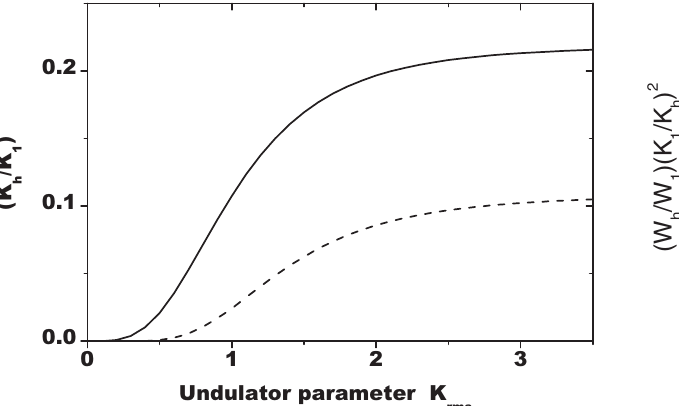
(cid:2) (cid:8) =W h 1 . SASE FEL T